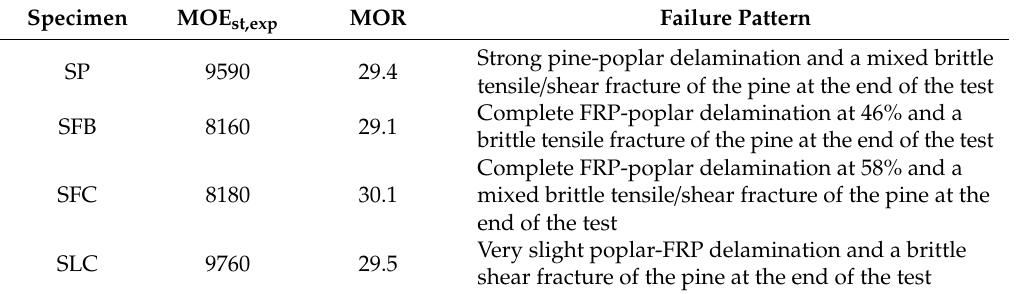
Figure 7. Experimental stress-time plot of tensile strain (gauge 3) for all the specimens. Table 5. Mechanical properties of each specimen experimentally